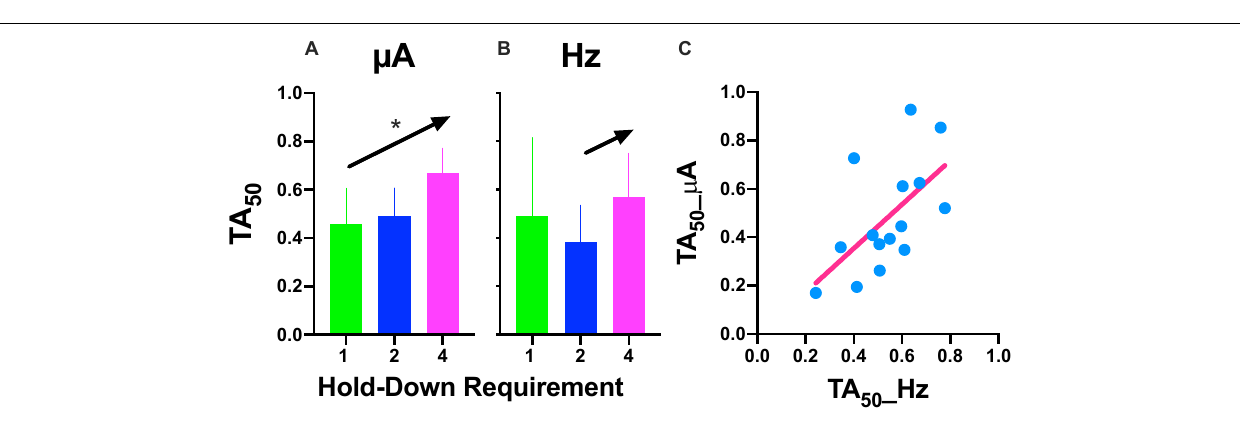
FIGURE 6 | (A) Time allocation (TA) 50 after intensity or frequency (B) variations. Mean ± SE (5 subjects) and arrows and * show a significant trend between the means. (C) Relationship between TA 50 observed after variations in frequency or intensity. Each point is the TA 50 of each rat plotted in common units (see text) at different prices (hold-down